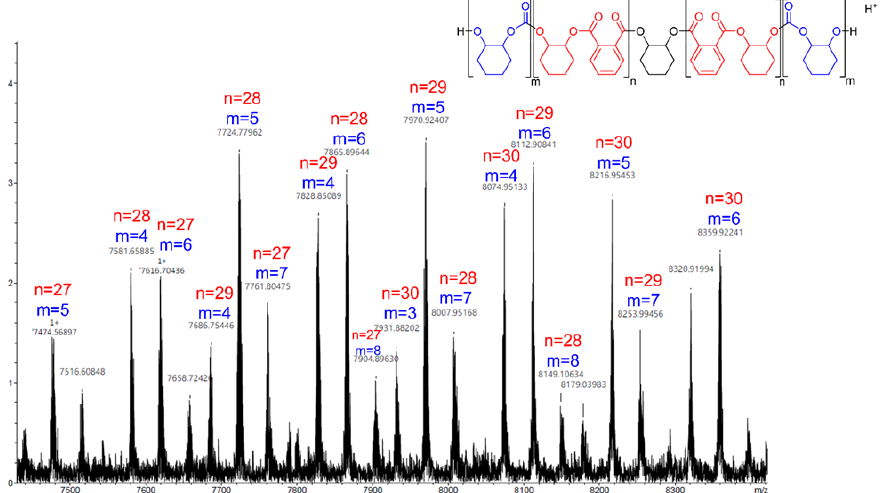
Figure 4. Expanded MALDI-ToF spectrum ranging from 7400 to 8500 m/z of the poly (cyclohexene phthalate-block-cyclohexene carbonate) obtained in entry 2 of Table 3. phthalate-block-cyclohexene carbonate) obtained in entry 2 of Table